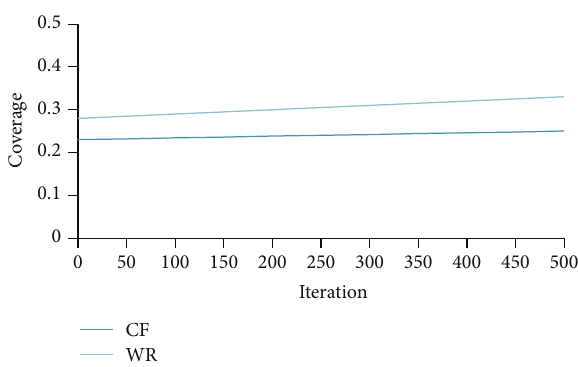
Figure 12: WebBluegillRecom-annealing system (WR) is compared to standard collaborative filtering (CF) system on variety averaged over 10 different runs per 1 active user, for 𝐼 = 5 recommendations, at iteration 100, 248